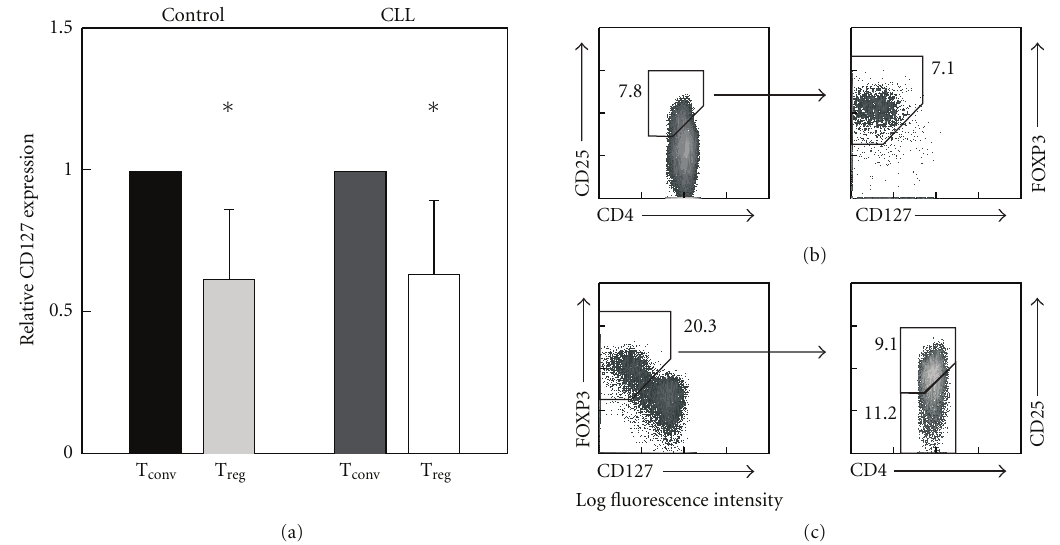
Figure 1: CD127 mRNA expression in CD4 + CD25 high T reg cells and integration of CD127 in the analysis of human T reg cells. (a) Expression of CD127 mRNA in CD4 + CD25 high T reg cells and conventional CD4 + CD25 − T cells in healthy donors ( n = 5, control) and CLL patients ( n = 5, CLL) as determined by qPCR ( ∗ , P < 0 . 05, Student’s t- test). (b) Gating strategies for analysis of expression of CD127 in CD4 + CD25 high FOXP3 + T reg cells or (c) CD25 expression in CD4 + CD127 low FOXP3 + T reg